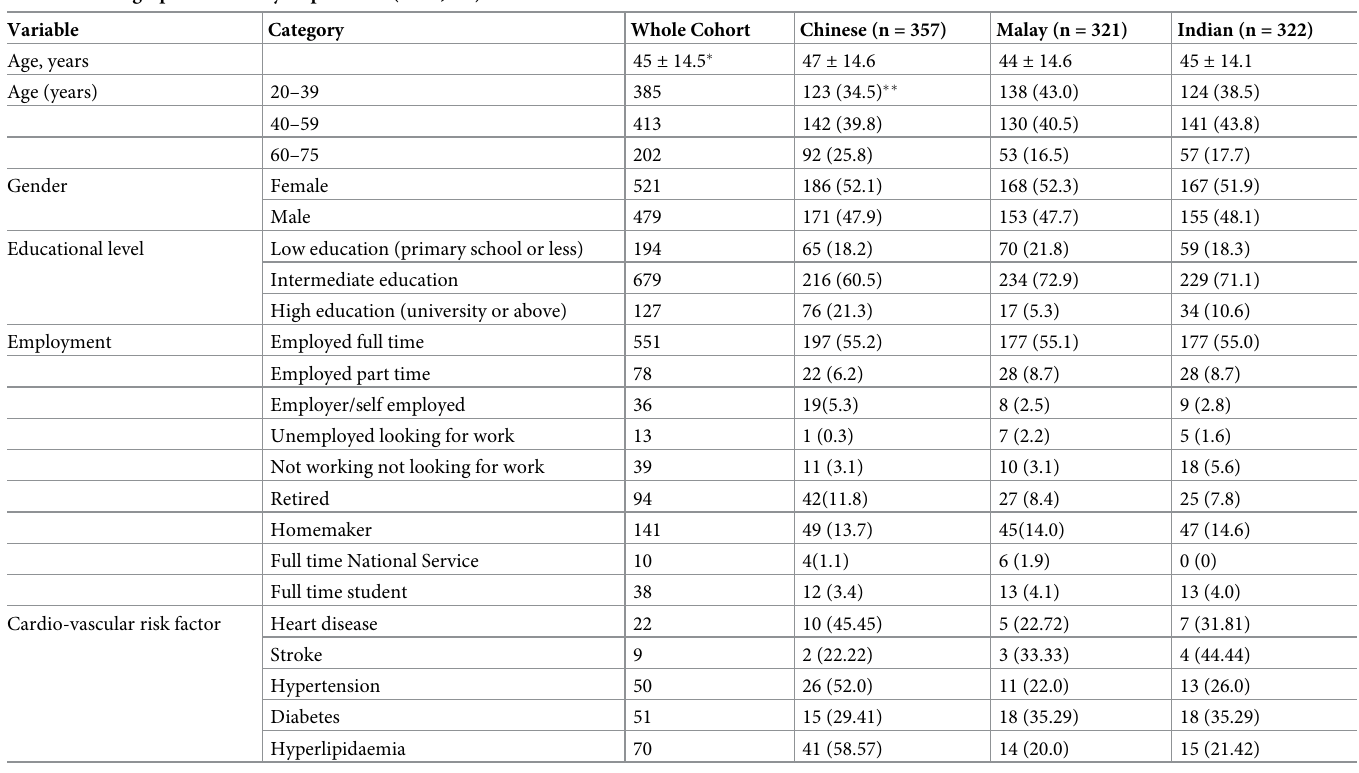
Table 1. Demographics of survey respondents (n =